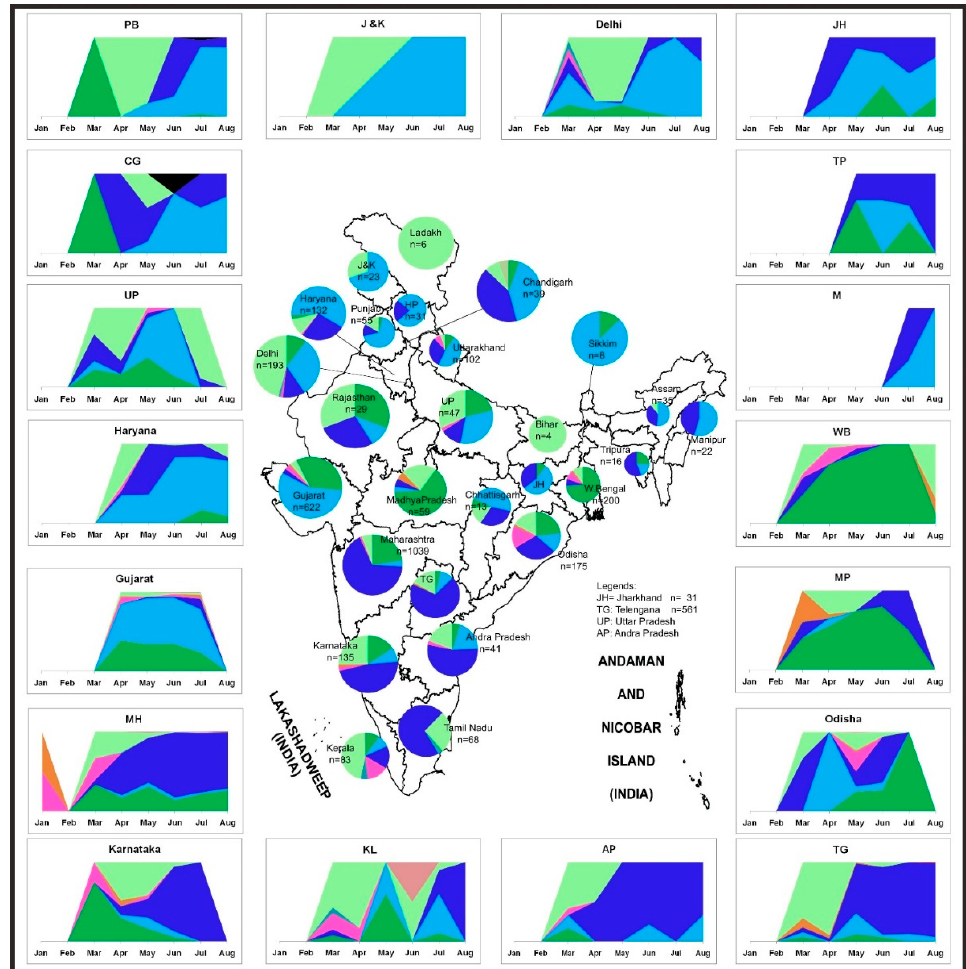
Figure 5. Distribution of the SARS-CoV-2 genome prevalence from the outbreak phase (January 2020) up to the seventh month of the pandemic. Stacked area plots are generated to demonstrate the cumulative temporal trends of the SARS-CoV-2 observed in the different states in India. The x-axis depicts the number of SARS-Cov-2 sequences observed in the respective months. The size of each pie chart within the states of the Indian map is proportional to the numbers in each respective clade. The outline of India’s map is downloaded from http://www.surveyofindia.gov.in/file/Map%20of%20India_1.jpg (accessed on 20 March 2020) and further modified to include relevant data in the SVG editor.